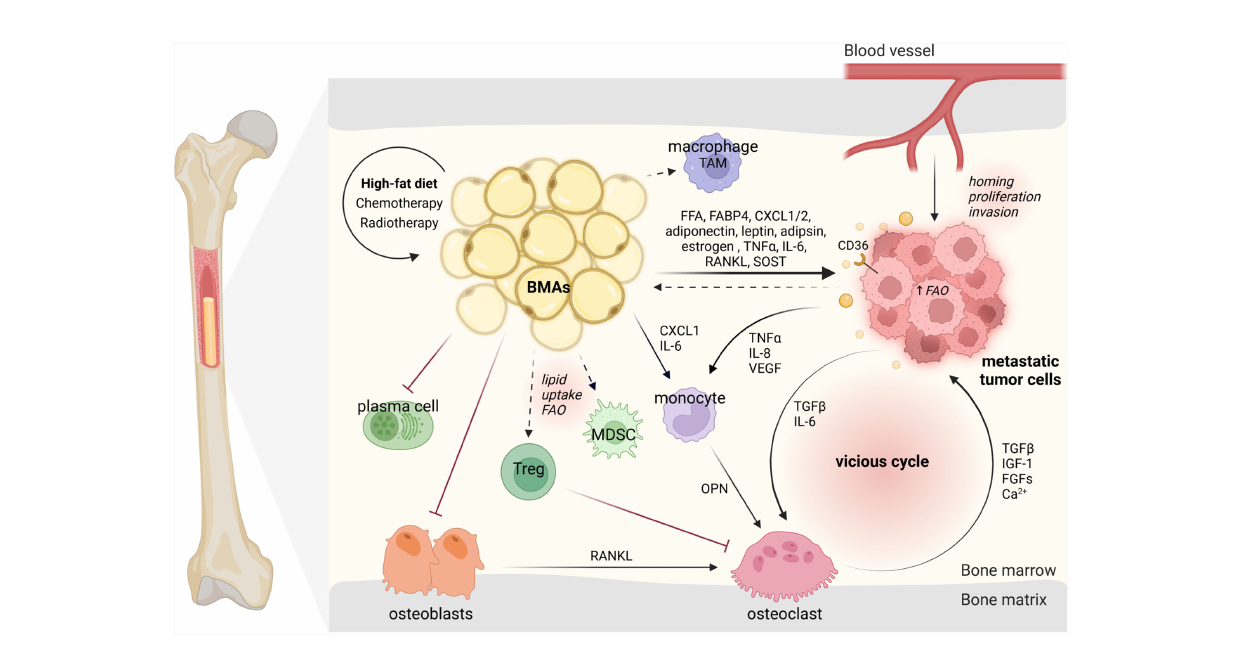
FIGURE 2 | BMAs modulate their surrounding microenvironment and interact with niching tumor cells and bone marrow-resident cells. BMAs, bone marrow adipocytes; TAM, tumor-associated macrophage; FFA, free fatty acid; FABP4, fatty acid-binding protein 4; CXCL1/2, C-X-C motif ligand 1/2; FAO, fatty acid oxidation; TNF a , tumor necrosis factor alpha; VEGF, vascular endothelial growth factor; TGF b , transforming growth factor beta; IGF-1, insulin-like growth factor-1; FGFs, fi broblast growth factors; OPN, osteopontin; RANKL, receptor activator of NF- k B ligand; Tregs, regulatory T cells. The dark arrows indicate relationships, while dashed arrows represent potential links (43, 44). Designed by